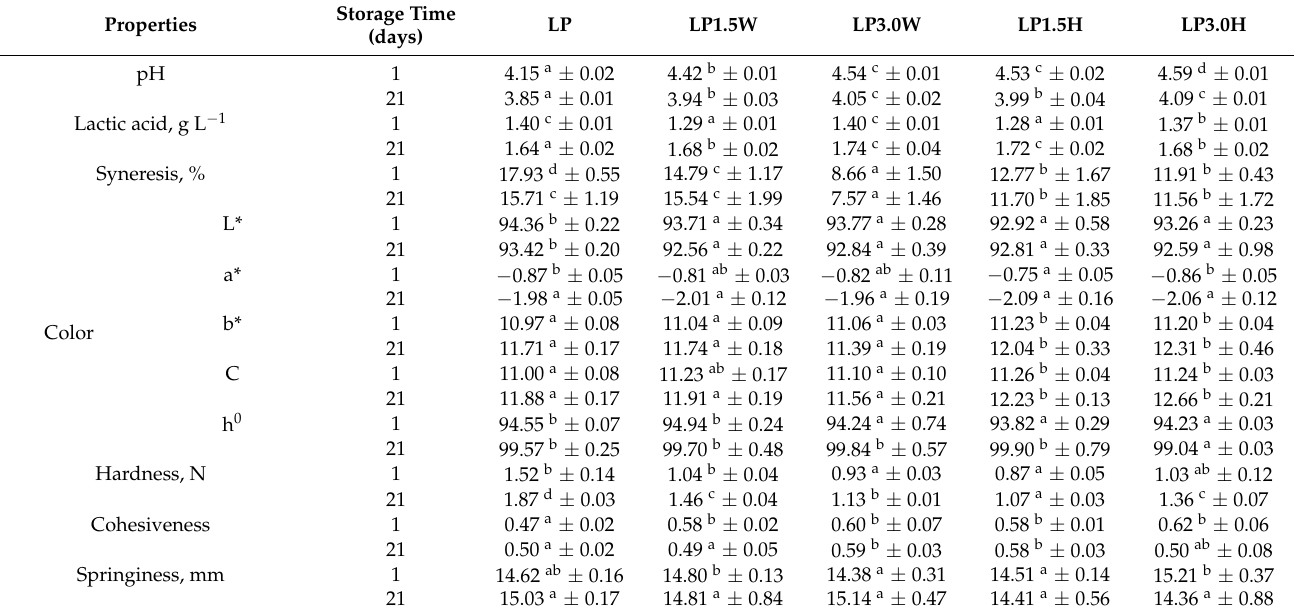
collagen hydrolysate and Lactobacillus acidophilus . Table 3. Acidity, syneresis, color and texture of sheep’s milk fermented by Lacticaseibacillus paracasei